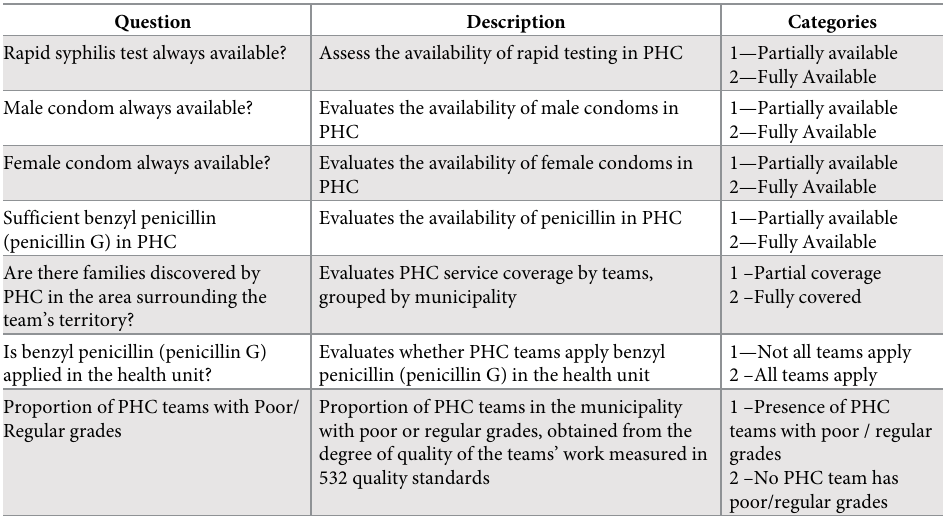
Table 1. PHC-related variables of the